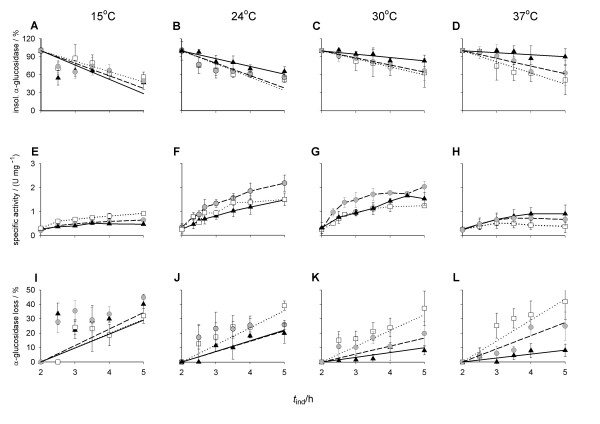
Kinetics of disaggregation, degradation and reactivation of α-glucosidase from inclusion bodies at various temperature. Cultures producing α-glucosidase in the wildtype strain with overexpression of ibpAB (black triangles, solid lines) or without (grey circles, dashed lines) and in the ibpAB deletion mutant (white squares, dotted lines) were incubated at 37°C to an OD600 of 0.5 and then induced with 1 mM IPTG. Two hours after induction, tetracycline was added to a final concentration of 25 μg mL-1, and the cultures were transferred to 15°C (A, E, I), 24°C (B, F, J), 30°C (C, G, K) or 37°C (D, H, L), respectively. Mean value and confidence interval of at least 2 (15 and 24°C) or 3–5 (30 and 37°C) independent experiments. Lines are from linear regression. (A-D) The amount of insoluble α-glucosidase was estimated by densitometry of Coomassie-stained SDS-PAGE gels and was referred to the value at the time of reactivation start (54 mg g-1 in the wildtype, 58 mg g-1 with overexpression of ibpAB and 49 mg g-1 in the deletion mutant). (E-H) α-Glucosidase activity and protein content were determined in cell extracts after disruption. Specific activity of α-glucosidase is given in units per mg of protein. (I-L) Degradational loss of α-glucosidase calculated as difference of the sum of soluble and insoluble α-glucosidase to the value obtained before addition of tetracycline. Time is given in hours after induction.